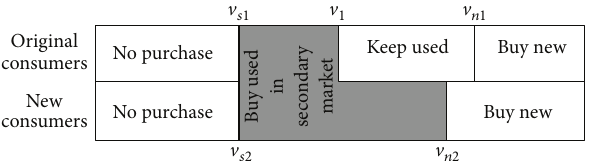
Figure 2: Purchase behavior of different